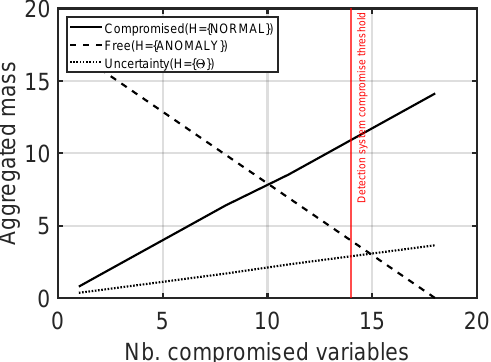
Figure 18. Progressive increase in the number of compromised detectors (compromised observable